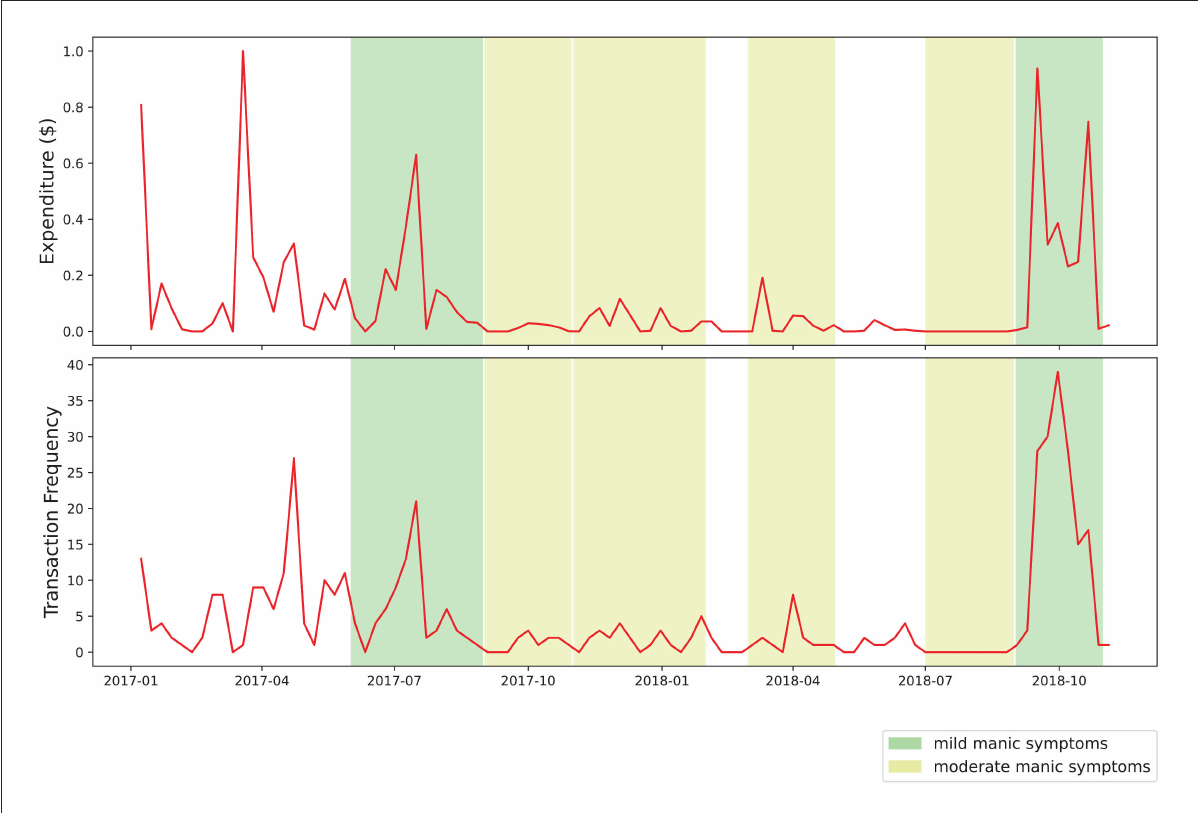
FIGURE3 Weekly expenditure from credit